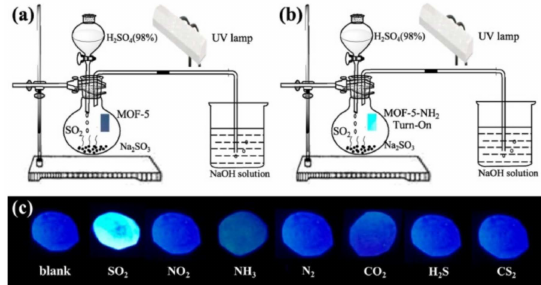
Figure 9. ( a , b ) Diagrams of the sensor for the detection of SO 2 gas using MOF-5 and MOF-5-NH 2 luminescent testing paper, and ( c ) luminescence response photos of MOF-5-NH 2 test paper after exposuretodi ff erentspeciesundera(365nm)UVlamp[66].